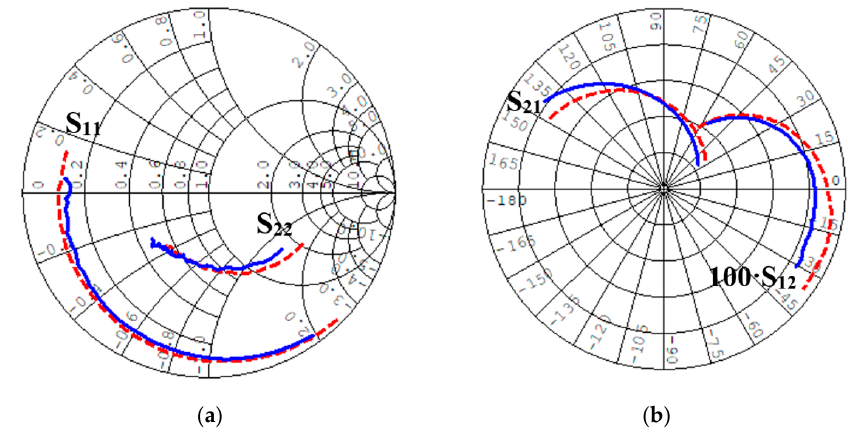
Figure 12. Scattering parameters measured by NRL with transmission lines (red dashed line) and UniME (blue solid line) for a HEMT with gate width of 4 × 50 μ m (3.5–26 GHz). ( a ) S 11 and S 22 , ( b ) S 21 and 100 S 12. . V DS = 2 V and I DS = 40 mA.